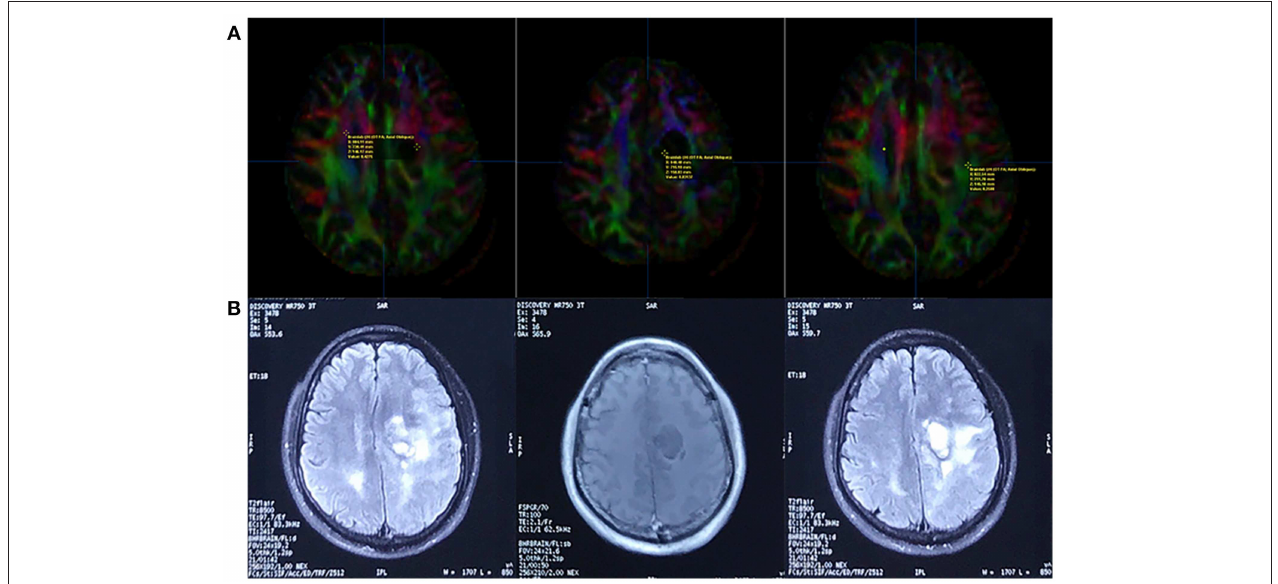
FIGURE 8 | Fractional Anisotropy (FA) parametric map based on DTI (A) and corresponding FLAIR/contrast-enhanced T1-weighted volume images (B) . The FA value of the contralateral normal white matter, non-enhancing tumor core, and edematous brain was 0.4275, 0.03137, and 0.2588, respectively (line A, from left to